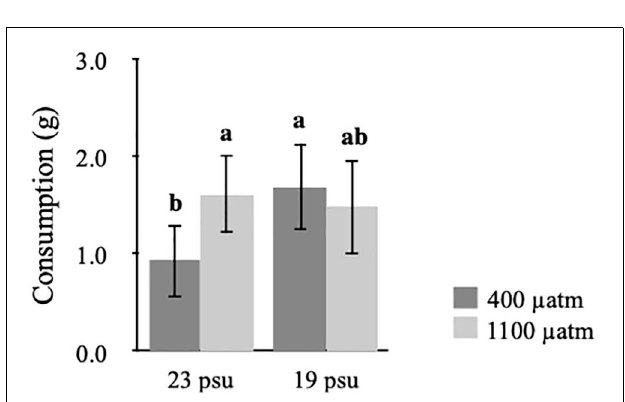
FIGURE 2 | Susceptibility, measured as consumption, of Fucus vesiculosus to Littorina obtusata after exposure to different levels of temperature (ambient and high), salinity (ambient and low), and pCO 2 (ambient and elevated) as fixed, orthogonal factors. Letters denote statistically significant post-hoc groupings (SNK post-hoc test, p < 0.05). Values are means ± 95% CI, n = 20.